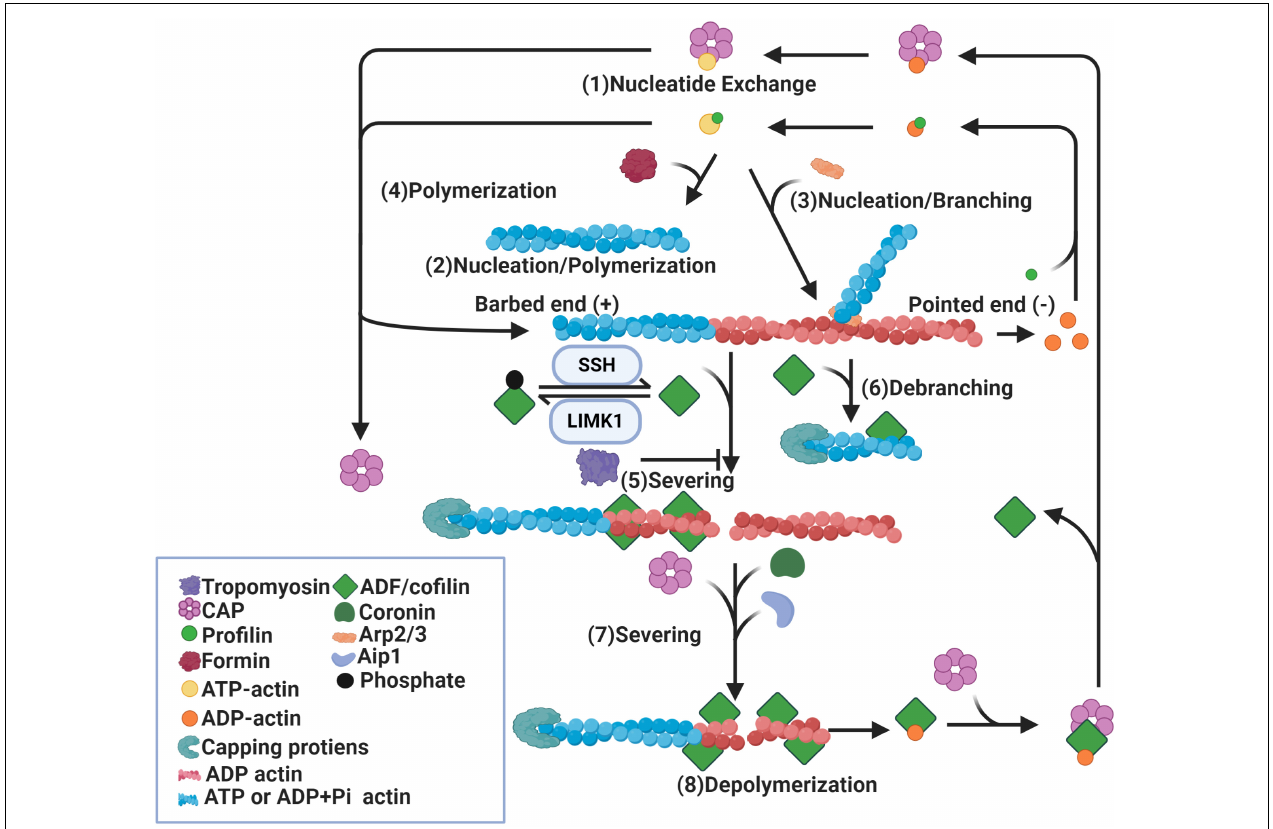
FIGURE 1 | Regulation of actin dynamics by ADF/cofilin. Binding of profilin on ADP-actin monomers induces nucleotide exchange (1). Formin (2) and Arp2/3 (3) induce nucleation of actin monomers and formation of actin filaments. While formin induces parallel actin filament (2), Arp2/3 promotes branching of the original filament (3). In addition, actin filaments can be polymerized by the addition of ATP-actin monomers at the barbed ends (4). Binding of dephosphorylated/active ADF/cofilin to ADP-actin subunits of actin filaments causes severing of these filaments (5) and depolymerization at pointed ends (8). ADF/cofilin activity is mediated by phosphorylation and dephosphorylation by LIMK1 and SSH respectively. ADF/cofilin also debranch Arp2/3 nucleated actin filaments (6). The severing activity of ADF/cofilin is enhanced by Aip1, coronin and CAP (7) and diminished by tropomyosin (5). Binding of capping proteins at barbed ends blocks the growth of newly formed actin segments. CAP also dissociates ADF/cofilin from ADP-actin monomers and promotes nucleotide exchange on these monomers